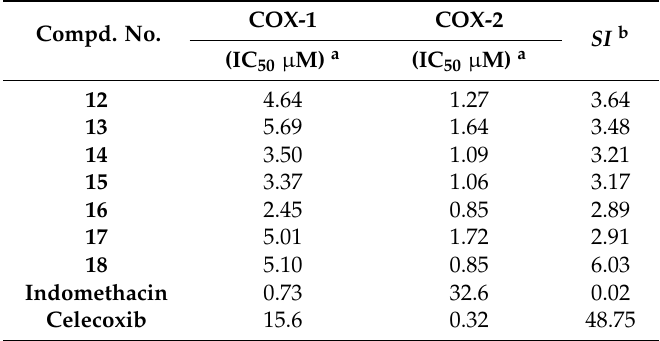
Table 1. In vitro COX-1/2 enzymes inhibition results of compounds 12 – 18 .